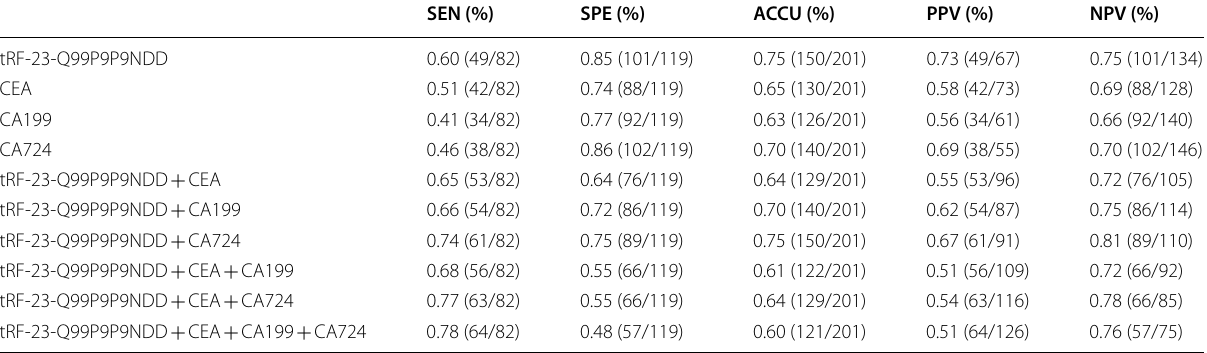
Table 4 The diagnostic performance of tRF-23-Q99P9P9NDD, CEA, CA199 and CA724 in differentiating early GC patients from healthy donors